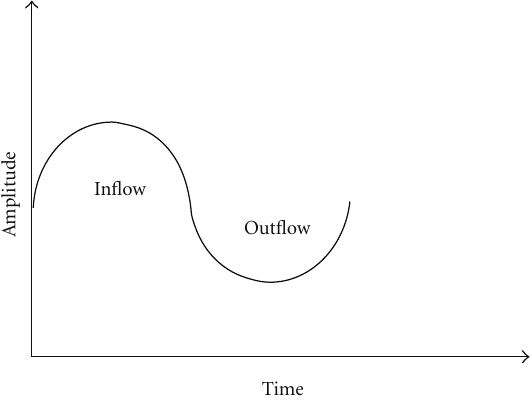
Figure 4: The sine function of periodical flow.